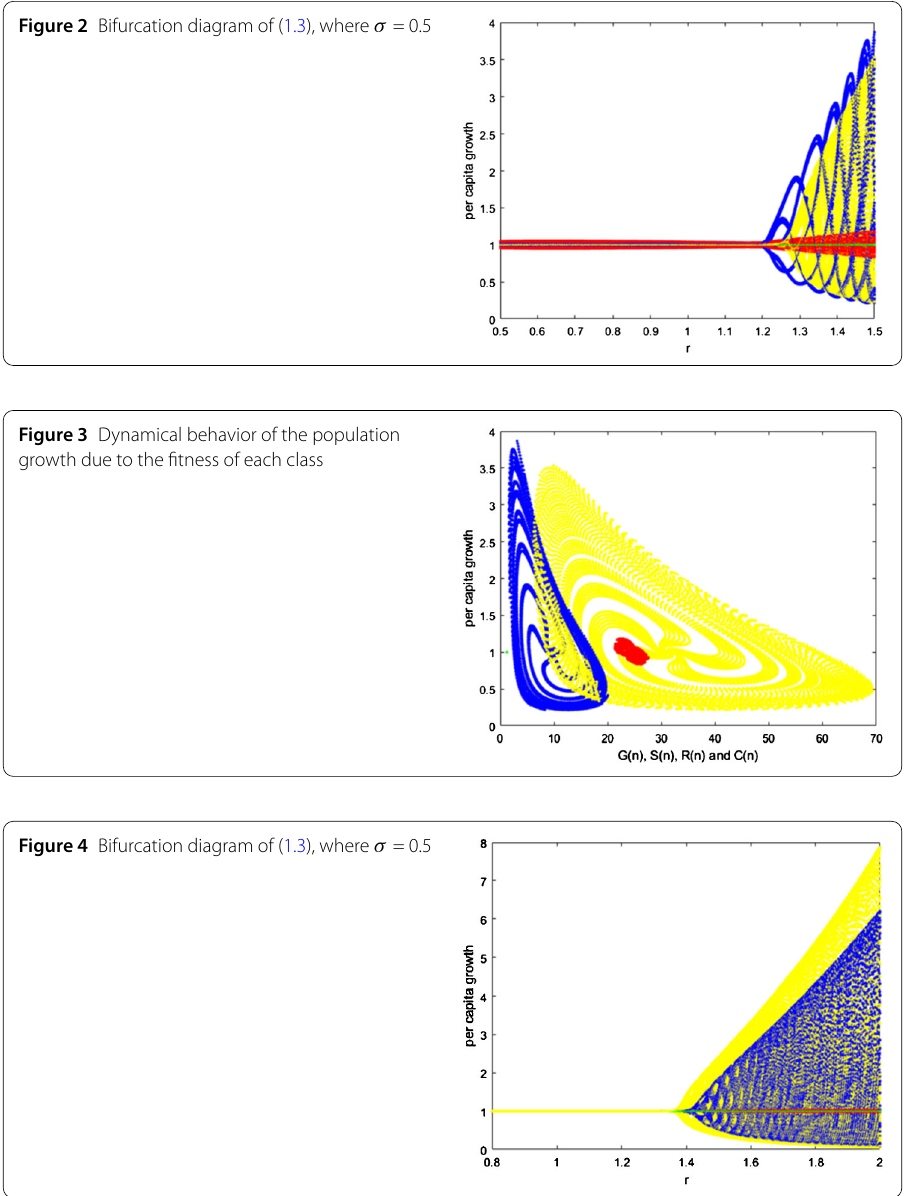
Figure 2 Bifurcation diagram of (1.3), where σ = 0.5